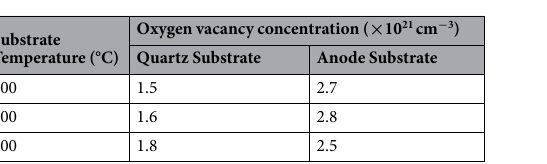
Table 1. Calculated oxygen vacancy concentration using spatial correlation model for the thin film with respect to substrate